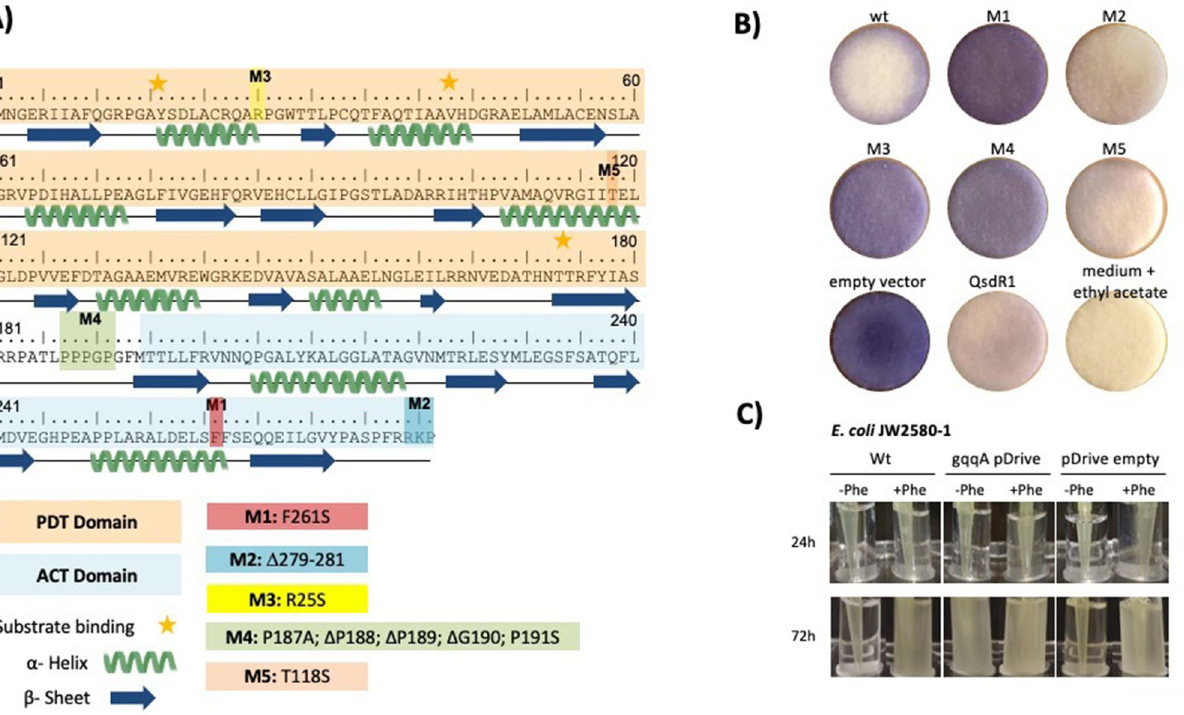
Figure 2. ( A ) Secondary structure of GqqA and ( B ) bioactivties of GqqA. The aa sequence of GqqA with the associated secondary structure is shown. The PDT domain is colored in orange and the ACT domain in light blue. The aa changes in the mutants (M1-M5) are highlighted in different colors. M1 (F261S) was shown in red, M2 (ΔRKP) in blue and M3 (R25S) in yellow. The modification at the loop (M 4) was highlighted in green and the aa exchange T118V (M5) in orange. ( B ) Bioindicator assay of an in vivo enzyme assay of GqqA wt and various mutants in E. coli . The reporter strain CV026 was used for indicating not degraded AI molecules (purple color) 52 . An active enzyme is shown by a colorless plate. An E. coli strain harboring the empty expression vector pET-21a was used as negative control. The quenching enzyme QsdR1 served as a positive control 30 . ( C